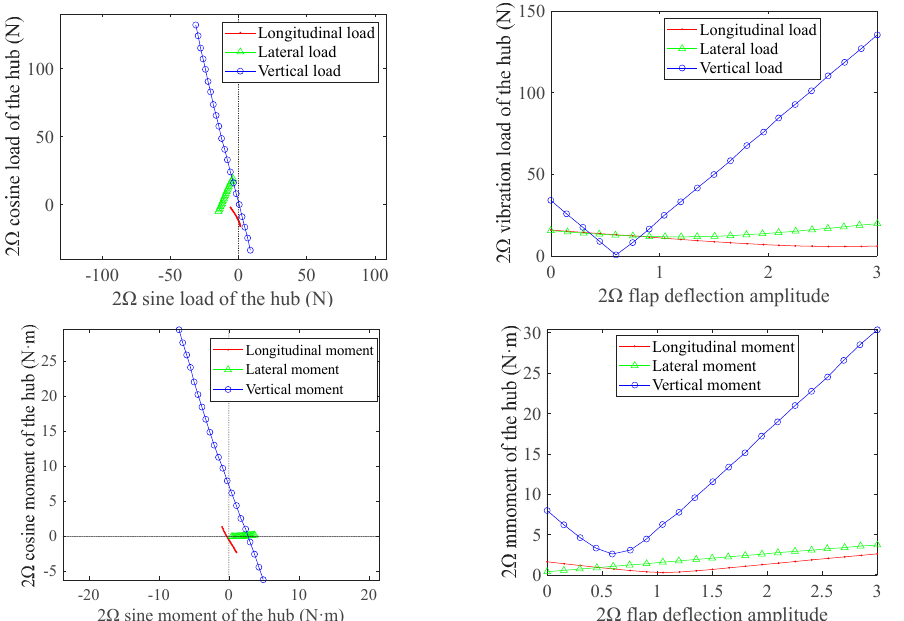
Figure 5. The effect of change in the higher-order flap amplitude on the vibration load and moment of the hub.